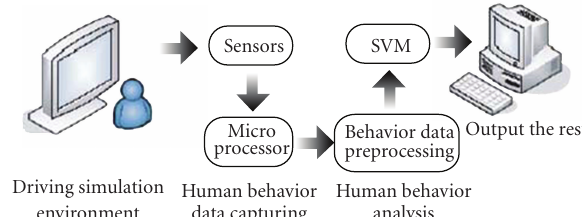
Figure 1: Architecture of the experimental system.